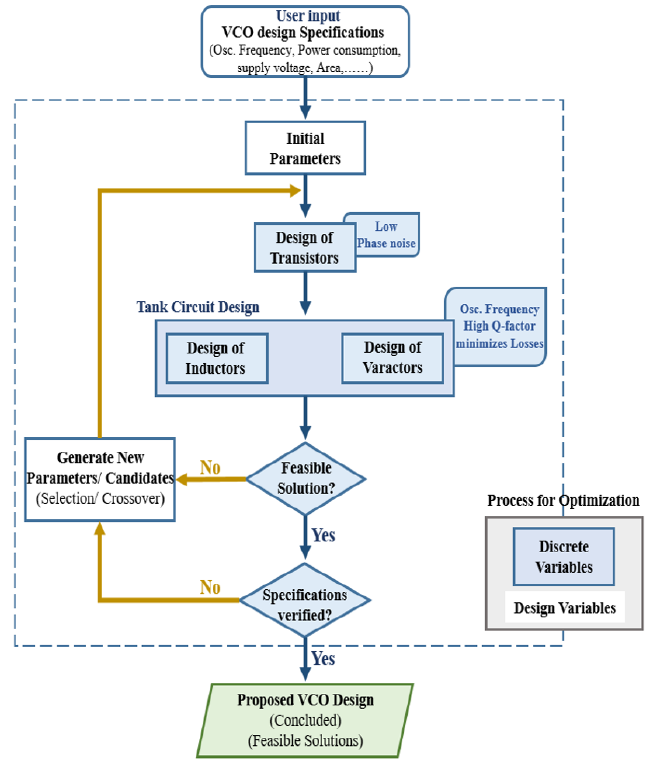
Figure 8. Designed VCO design flowchart.